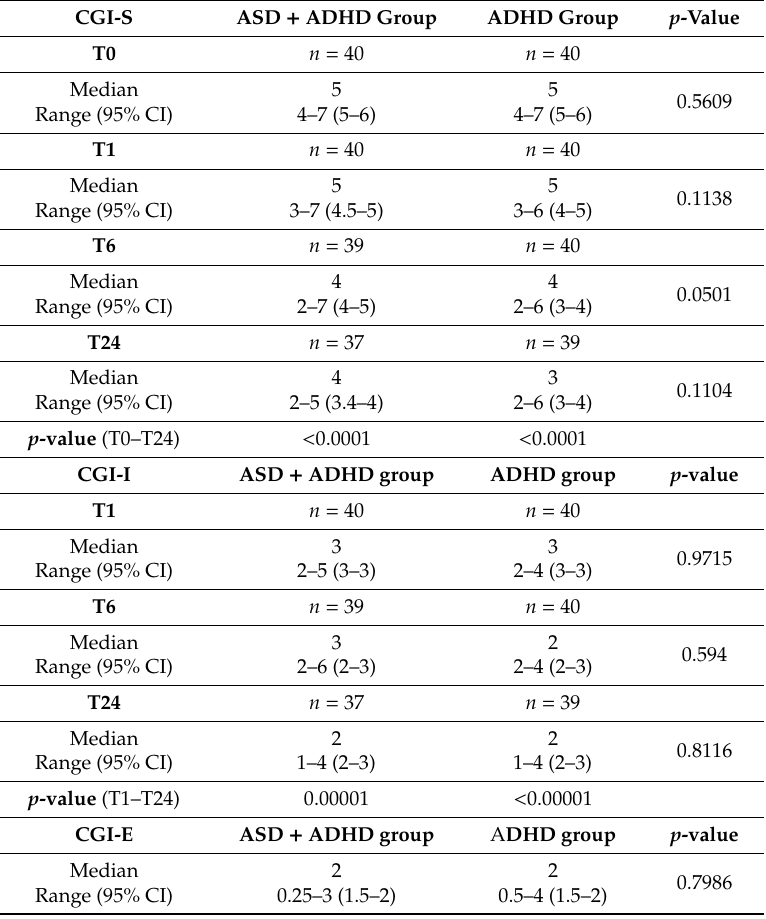
Table 3. Clinical global impression scale (CGI)